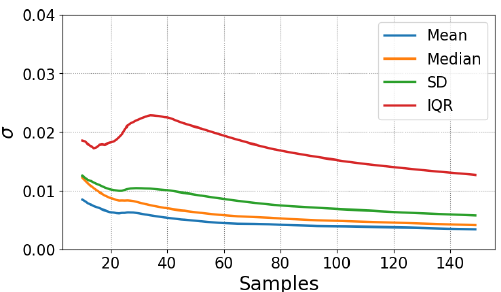
Figure 22. Convergence of the population estimates for a deep stall case as the number of tests